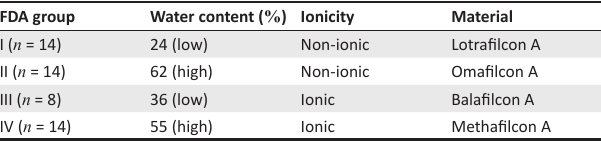
TABLE 1: Contact lenses selected for the study, with number of lenses used per Food and Drug Administration group. FDA